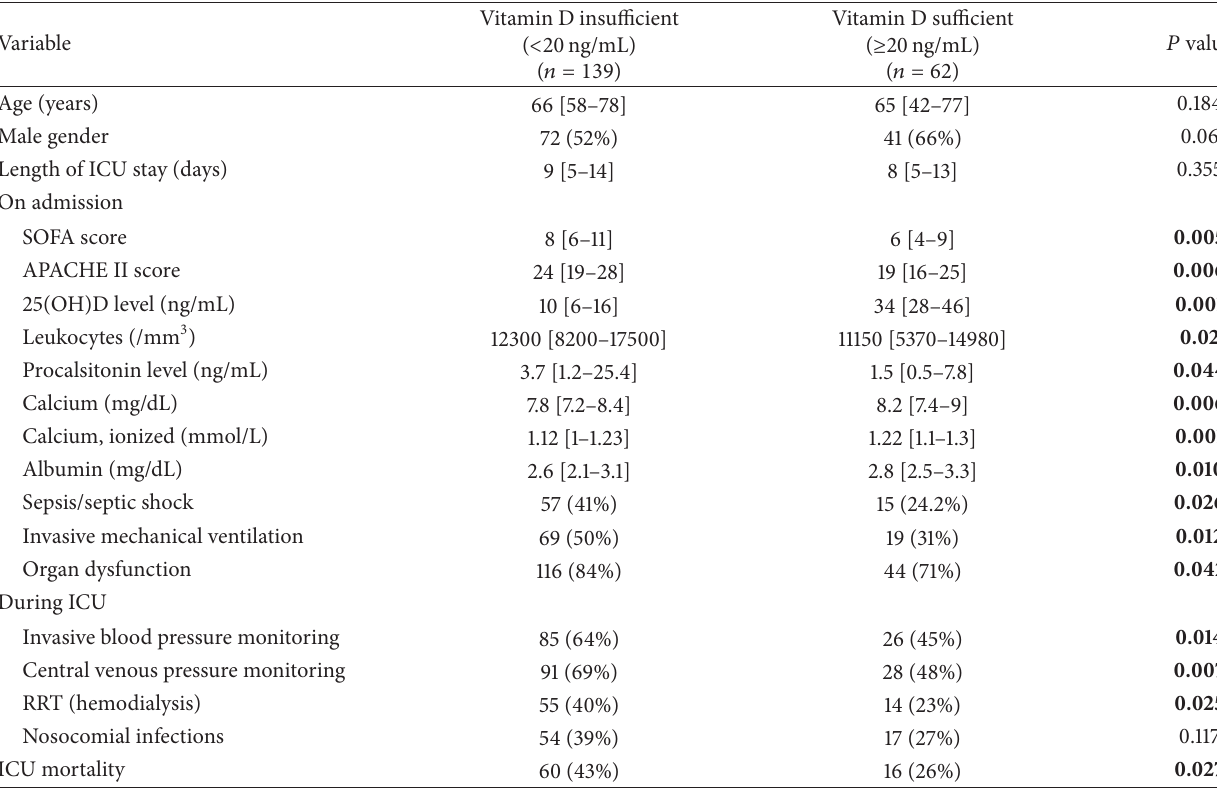
Table 2: Comparison of patients who were vitamin D insufficient and